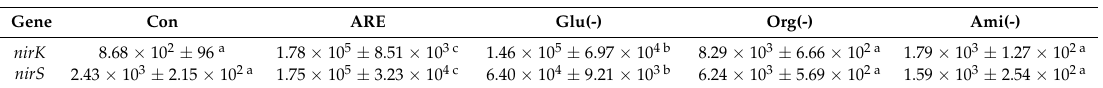
Table 2. The abundance of denitrifying bacteria, by genes of nirS and nirK copies per gram in different CWs (gene copies g − 1 ), values are expressed as means ± sd ( n = 3). Gene Con ARE Glu(-) Org(-) Ami(-)